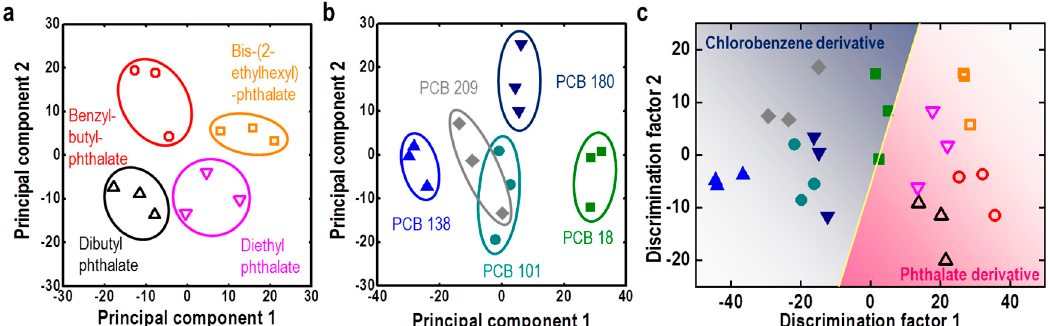
Figure 10. ( a ) PCA analysis of phthalate derivatives, ( b ) PCB derivatives, and ( c ) LDA analysis of phthalate and PCB derivatives using a M13 bacteriophage-based color sensor. Reproduced from [65], with permission from Elsevier, 2017.